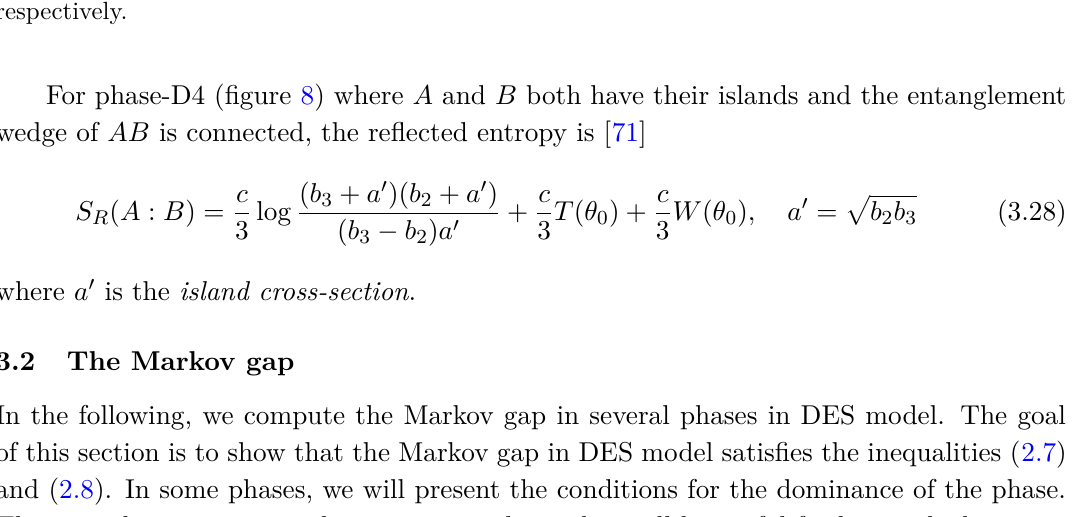
Figure 5 . Phase-D1. The blue and yellow regions are the entanglement wedges of A and B ,